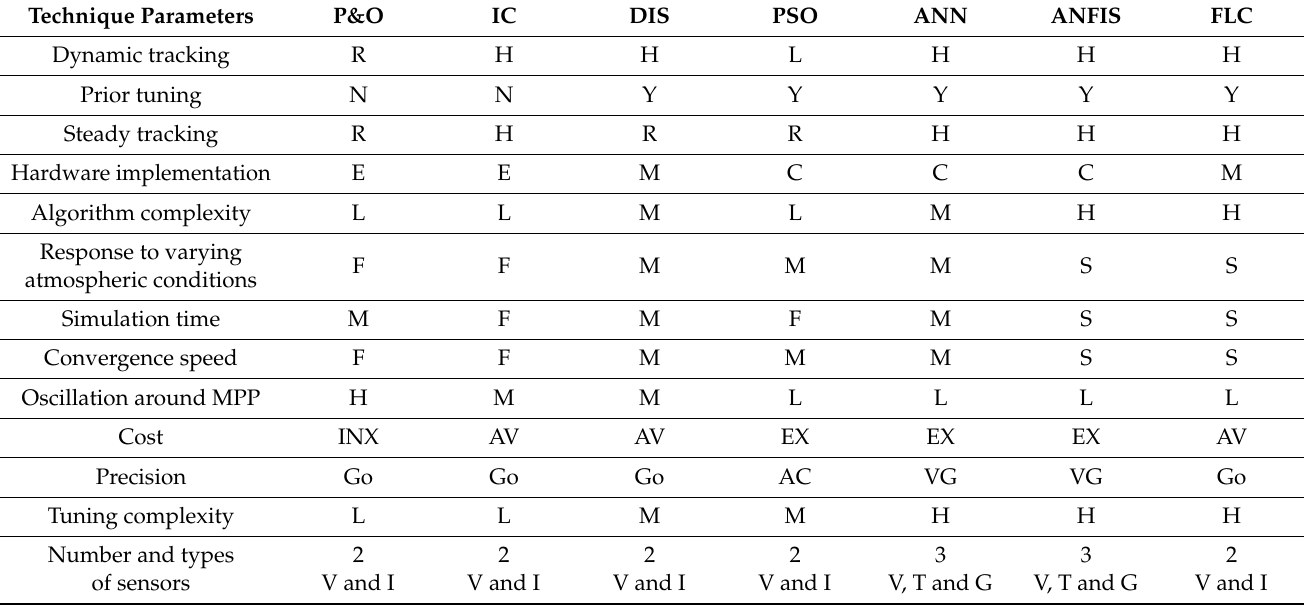
Table 9. Benchmark of MPPT